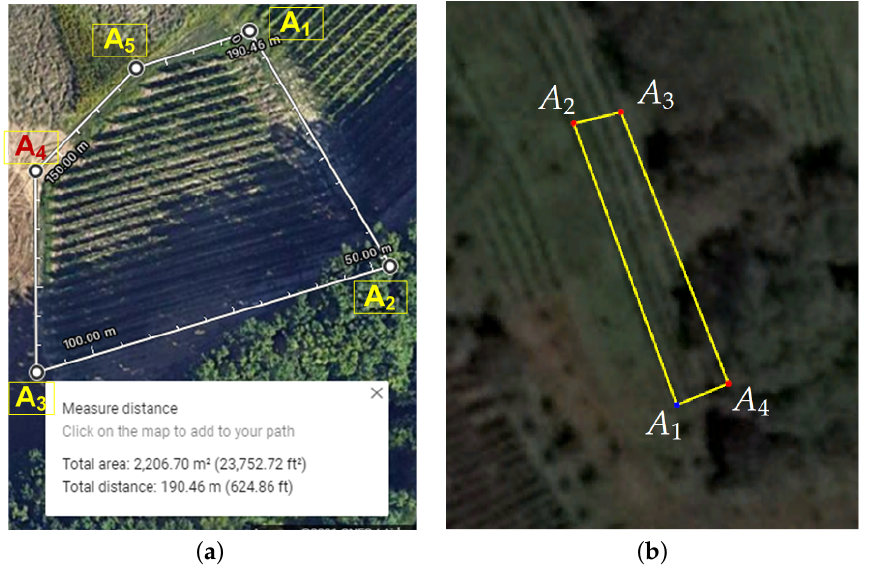
Figure 6. Two vineyards that were selected for conducting experiments to validate the proposed en- ergy consumption assessment method. ( a ) The section of the Jazbina vineyard taken as an example for formal description of a vineyard. The GPS coordinates of the vertices of the vineyard pentagon were obtained from the Google Maps application: A 1 ( 45.855934,16.006050 ) , A 2 ( 45.855604,16.006341 ) , A 3 ( 45.855302,16.005694 ) , A 4 ( 45.855745,16.005620 ) and A 5 ( 45.855888,16.005864 ) . ( b ) Section of the Zelina vineyard. The steepest part of the vineyard, where the experiments took place, is marked. GPS coordinates of the vertices: A 1 ( 45.960515,16.220710 ) , A 2 ( 45.960871,16.220513 ) , A 3 ( 45.960882,16.220559 ) , A 4 ( 45.960526,16.220787 )